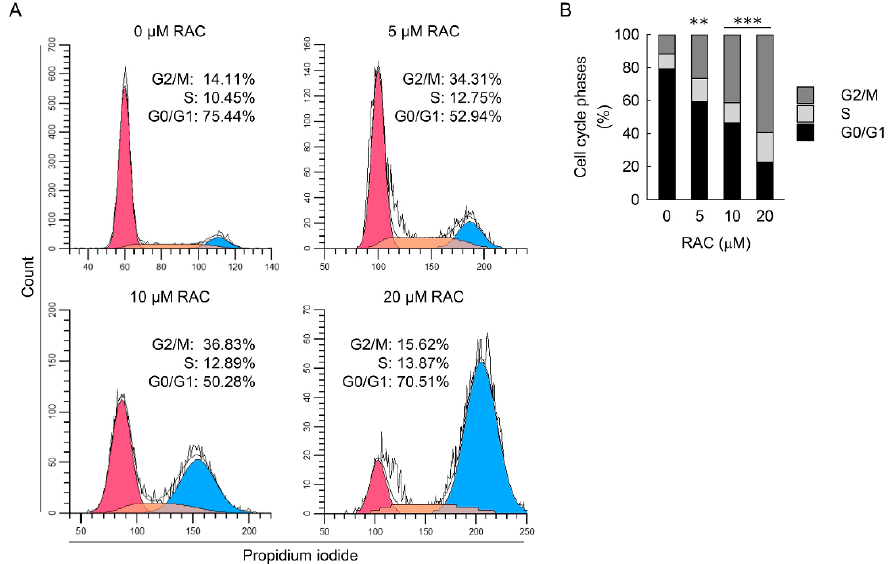
Figure 6. Repeated administration of cisplatin (RAC) leads to G2/M cell cycle arrest in kidney fibroblast cells. Normal rat kidney fibroblast NRK-49F cells were treated with 0, 5, 10, or 20 μM cisplatin in normal culture media for 6 h, and the media were replaced with normal culture media, followed by incubation for 18 h. The experiment was repeated three times, and finally, the cells were harvested at 72 h after the first treatment. ( A ) Representative histogram of cell cycle using the CytoFLEX flow cytometer (Beckman Coulter, Indianapolis, IN, USA), CytExpert software (Beckman Coulter), and Modfit LT 5.0 software (Verity Software House, Topsham, ME, USA). ( B ) Quantification of cell cycle phases using Modfit LT 5.0 software ( n = 4 experiments). Data are presented as mean of cell cycle phases. Statistical significance was determined by two-way analysis of variance (ANOVA) followed by Tukey’s post hoc test (effect of RAC, F 3,48 = 0.0000208, p = 1.000; effect of cell cycle, F 2,48 = 146.699, p < 0.001; interaction between RAC and cell cycle, F 6,48 = 49.164, p < 0.001). ** p < 0.01, *** p < 0.001 versus 0 μM RAC.